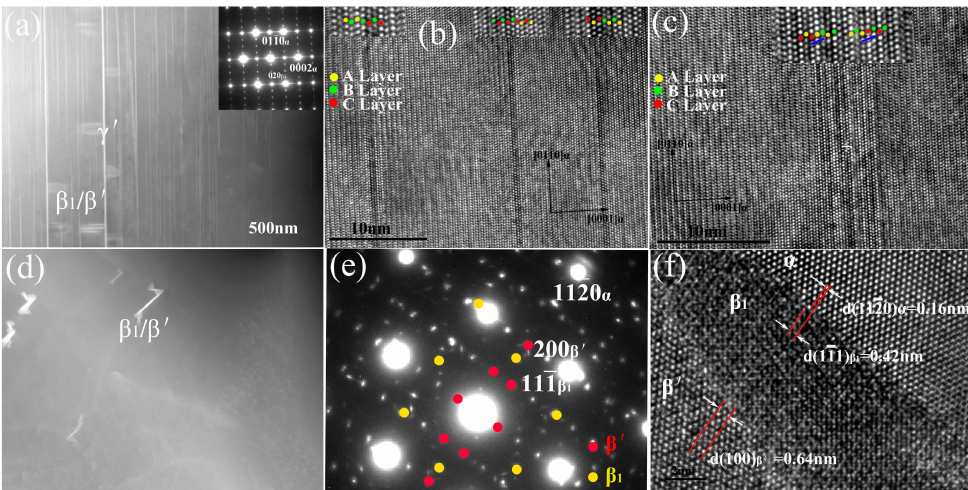
Figure 4. Microstructure for alloy aged for 200 h: ( a ) HAADF image; ( b ), ( c ) HRTEM images taken (cid:2) (cid:3) along 2110 ; ( d ) bright-field image; ( e ) SAED pattern; and ( f ) HRTEM image taken along [ 0001 ] α